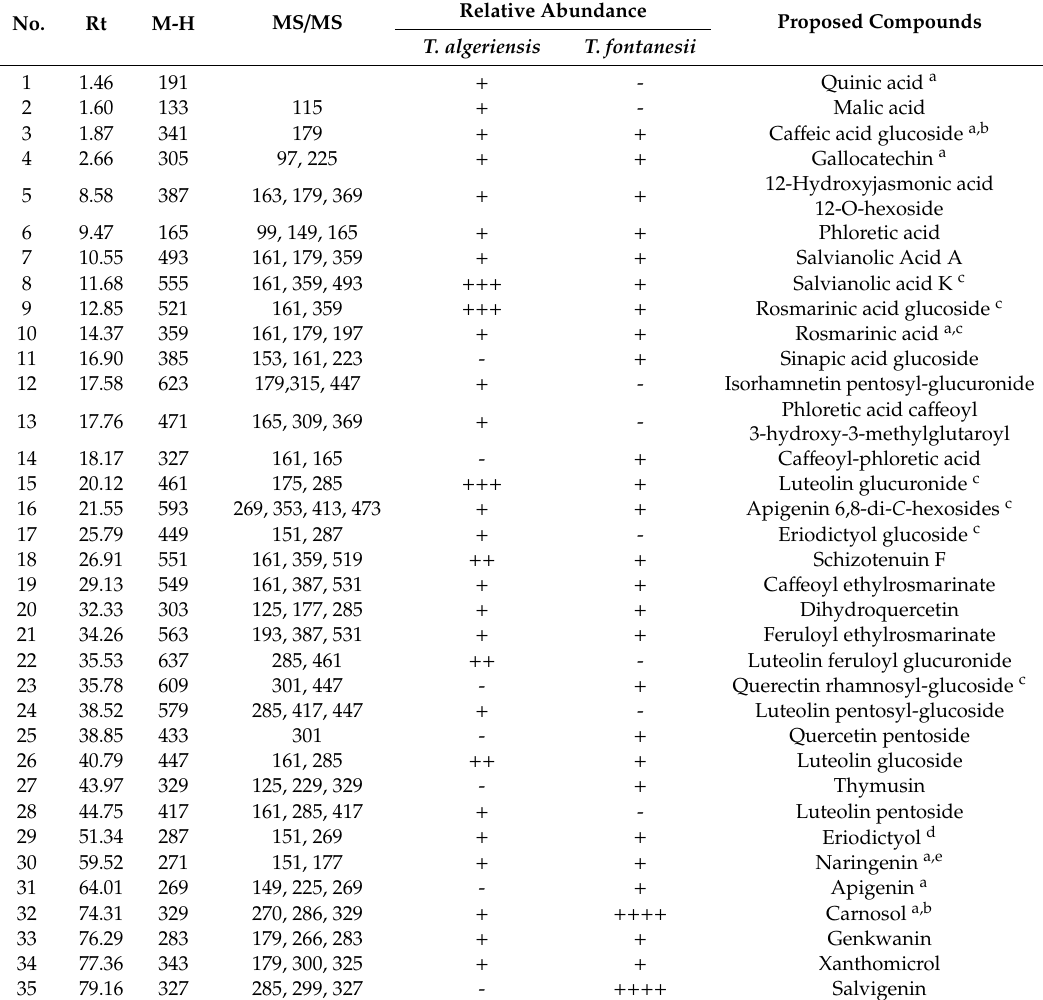
Table 1. Secondary metabolites from T. algeriensis and T. fontanesii leaves